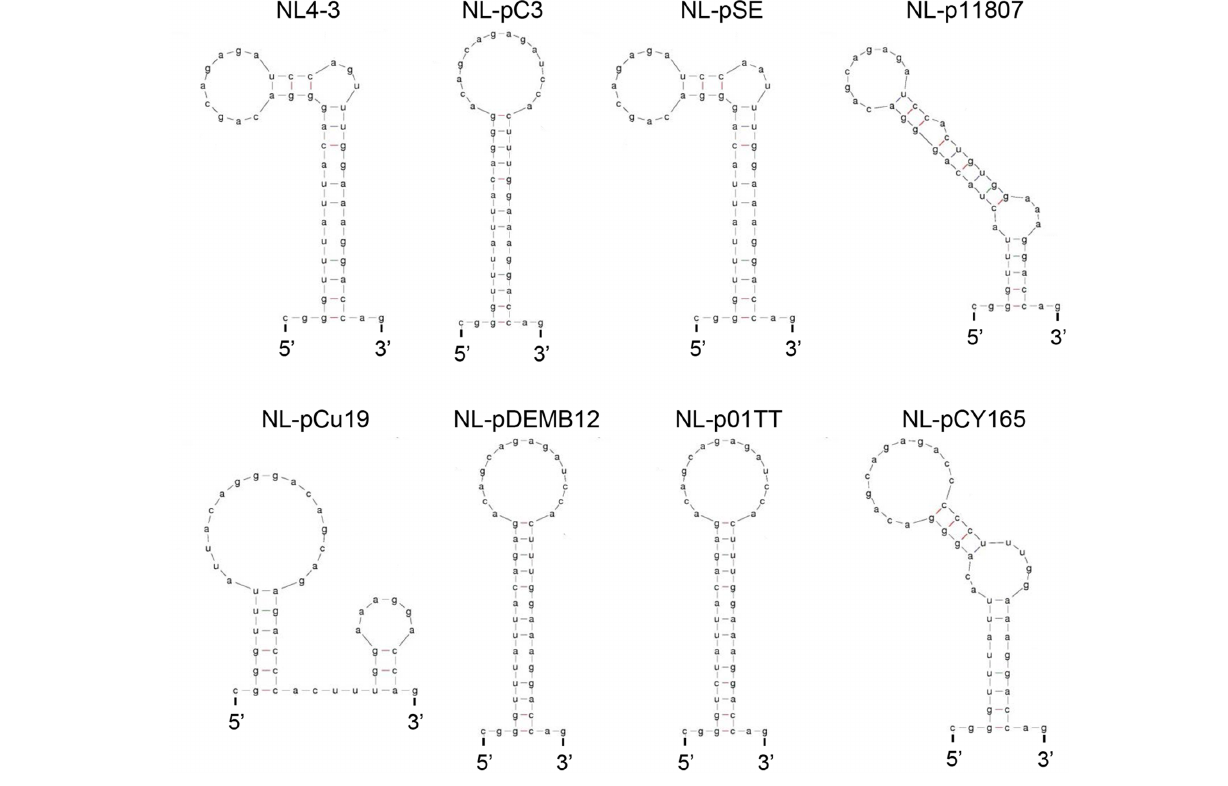
FIGURE 13 | Secondary RNA structures of SLSA1 in naturally occurring full-length SA1D2prox sequences. RNA structural shapes predicted by mfold program (Zuker, 2003) are shown for viral clones in Figure 11 .